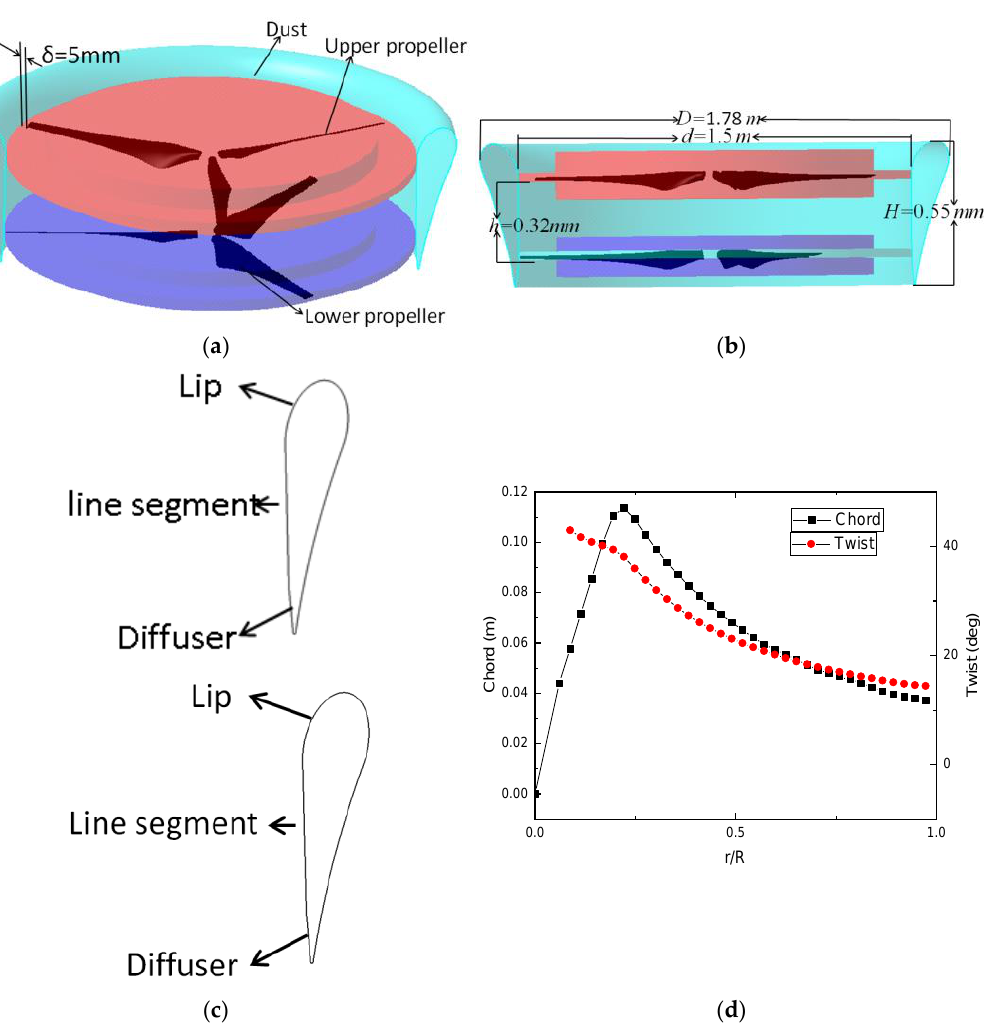
Figure 2. Introduction of DCP parameters. ( a ) parts diagram; ( b ) main parameters; ( c ) duct airfoil; ( d ) propeller chord and twist.